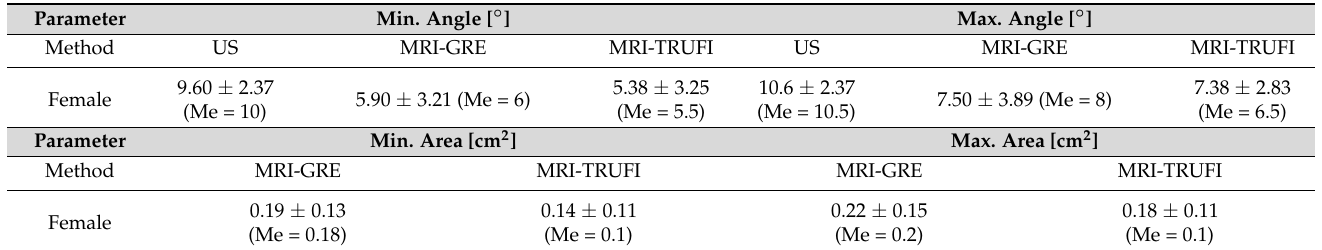
Figure 7. The minimum and maximum values of the area of the rima glottidis compartments obtained with the use of dynamic MRI sequences in the group of patients without VF mobility abnormalities in comparison to the preoperative examination. Table 1. The minimum and maximum angles and the areas of the vocal folds in the group of patients with abnormal postoperative VF mobility obtained during normal breathing via US and MRI.